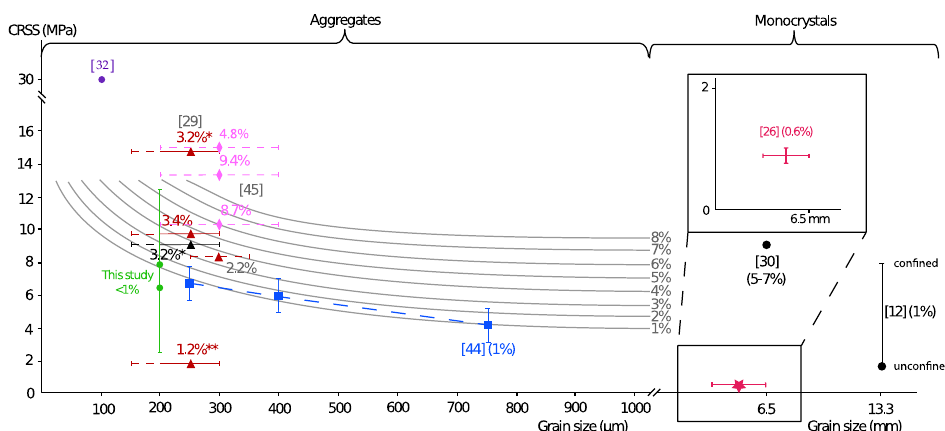
Figure 28. Summary of the current knowledge about the evolution of the CRSS value as a function of grain size and strain. The figure was modified from an initial drawing by Amrouch [41] on the basis of data by Rocher [44]. Constraints from the earlier and present studies are reported [12,26,29,30,36,44,45]. * Initial value from Lacombe and Laurent [29] re-evaluated by Rocher [44]. ** Outliers due to data issues.